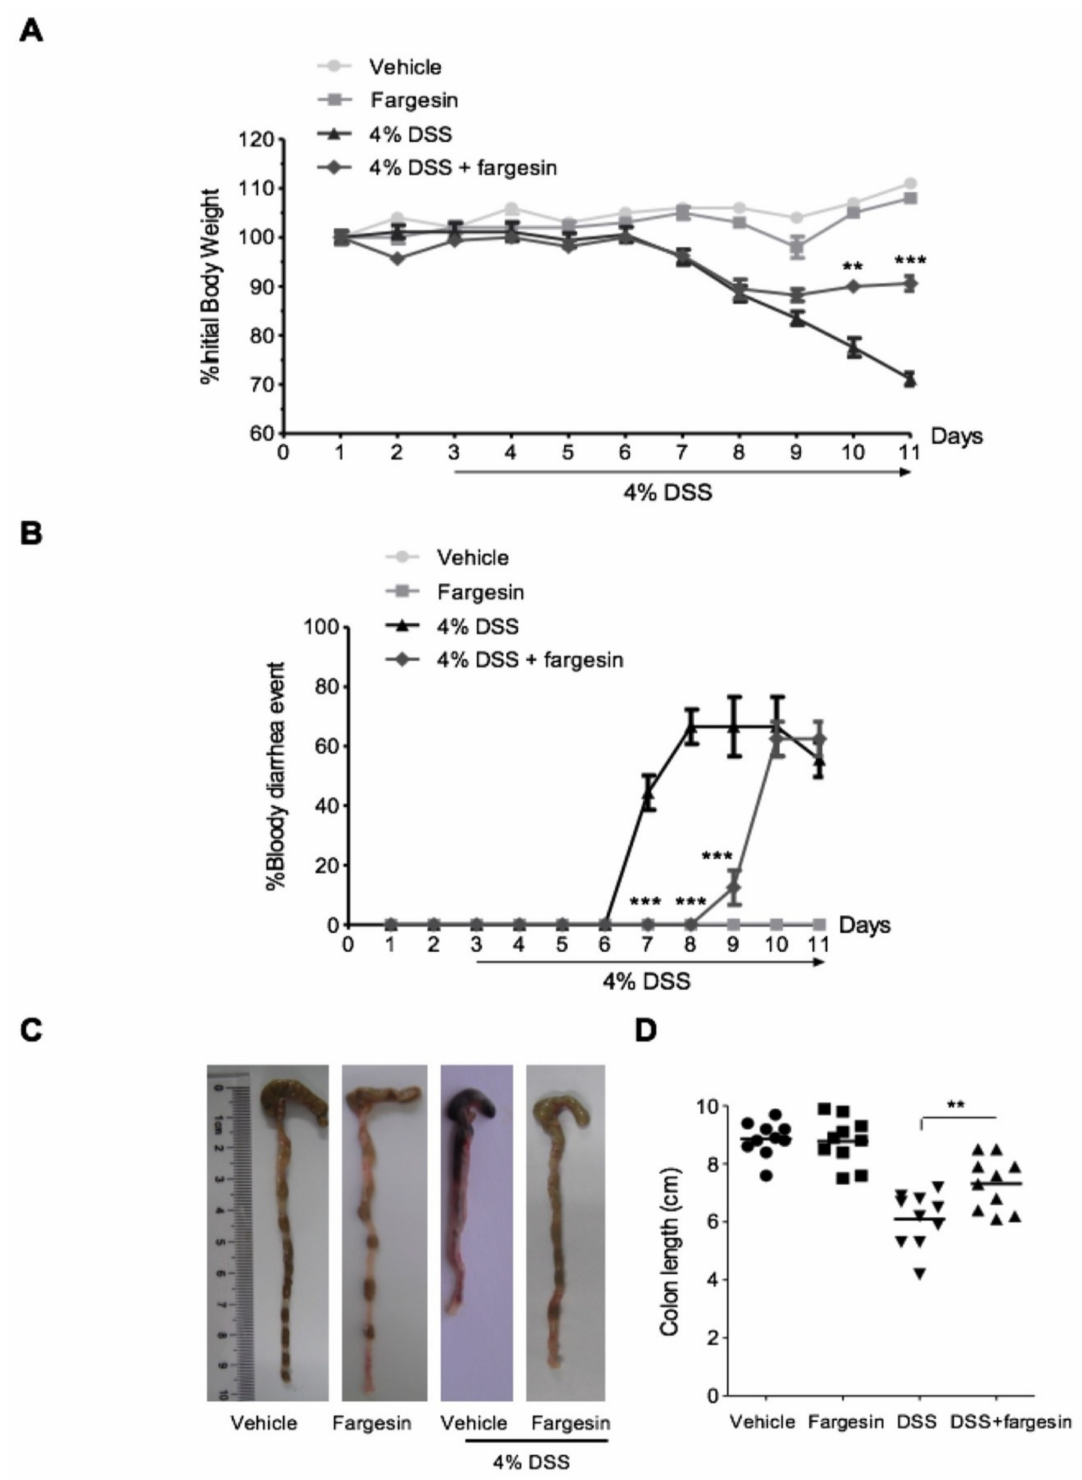
Figure 1. Macroscopic assessment of DSS-induced colitis. ( A ) Body weight changes following DSS induction of colitis. Data were plotted as the percentage of basal body weight. ( B ) The occurrence of bloody diarrhea. Data were plotted as a percentage of the total mice that had bloody diarrhea at different time points of DSS treatment. ( C ) and ( D ) Macroscopic observation and assessment of colon shortening. Values were expressed as the mean ± SD of n = 10 mice in each group. ** p < 0.01, *** p < 0.001 vs. DSS-treated